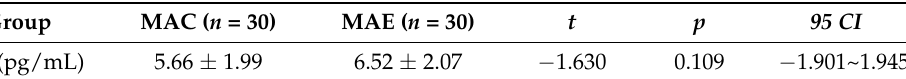
Table 4. Plasma NfL levels in MAE and MAC groups.